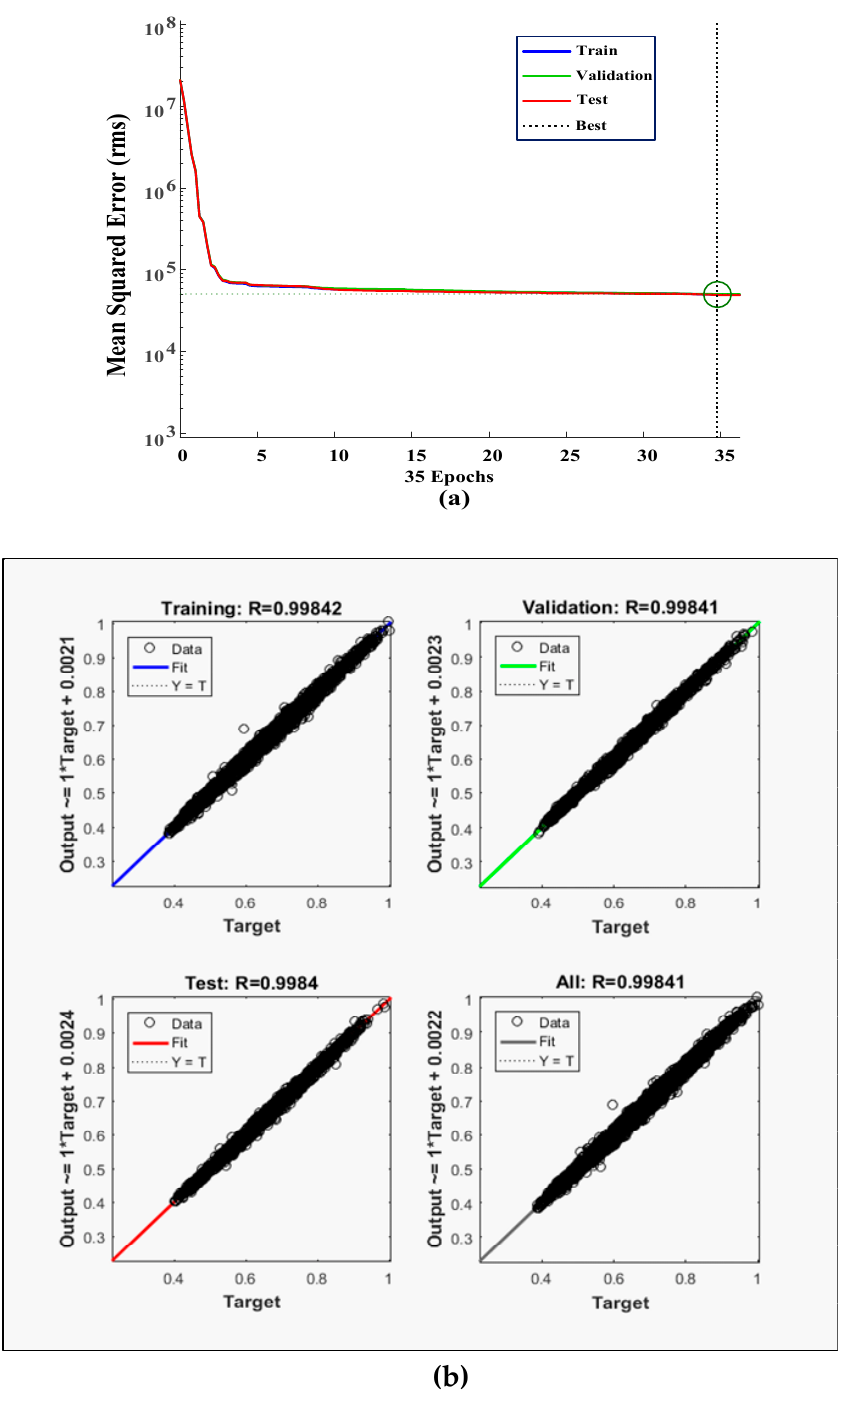
Figure 15. ( a ) Model performance validation and ( b ) model regression plot.